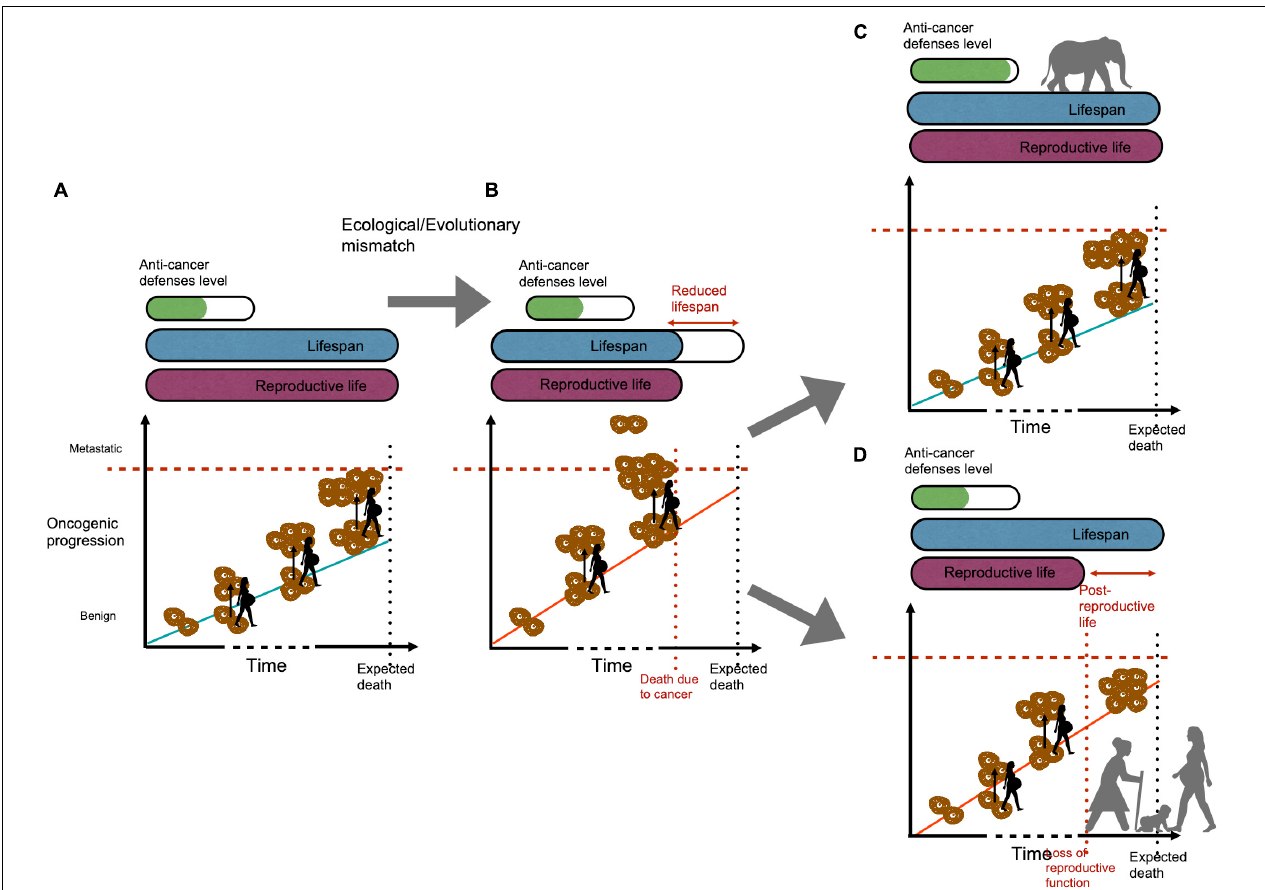
FIGURE 4 | Menopause as a possible (transient) adaptation to cancer risk following an evolutionary mismatch. (A) When cancer defenses are in alignment with malignant risks, oncogenic processes slowly accumulate through time, and even if pregnancy periods exacerbate their dynamics, the risk of metastatic cancers remains low. (B) Following an ecological and/or evolutionary mismatch, cancer defenses may become too weak given the novel cancer risks. Oncogenic processes accumulate rapidly, and this time reproductive episodes exacerbate metastatic cancer risks sooner in life for females, resulting in a short lifespan and a low fitness. From this situation, two evolutionary outcomes are possible, natural selection can (i) favor the evolution of better cancer defenses in these species (i.e., as in large animals such as whales and elephants), coming back to a situation comparable to (A) , here (C) , or (ii) favor females ceasing their reproduction prematurely to preserve their health and invest their energy/resources for their grandchildren (D) . In this later situation, female’s fitness is higher than in (B) because of inclusive fitness. The (D) scenario could in theory be just a transient situation until other cancer defenses are selected ( A,C examples). Figure modified from Thomas et al.